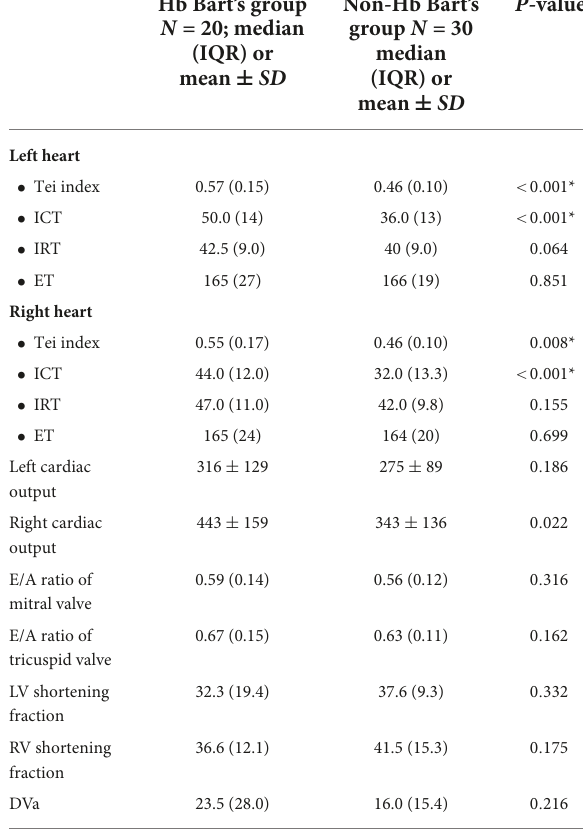
TABLE 2 Prenatal 2D-ultrasound findings and spectral Doppler studies.